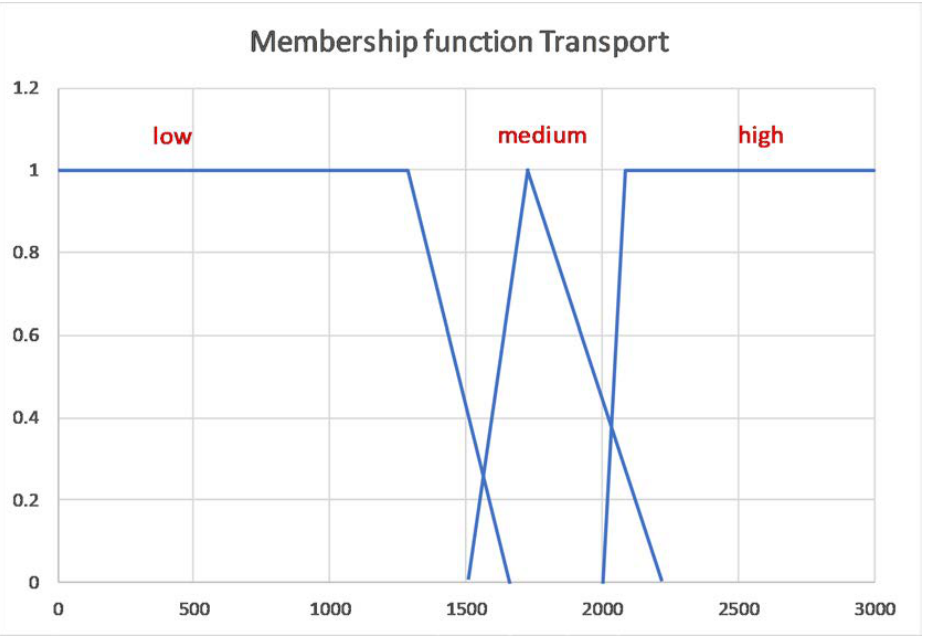
Figure 4. Membership function transport.